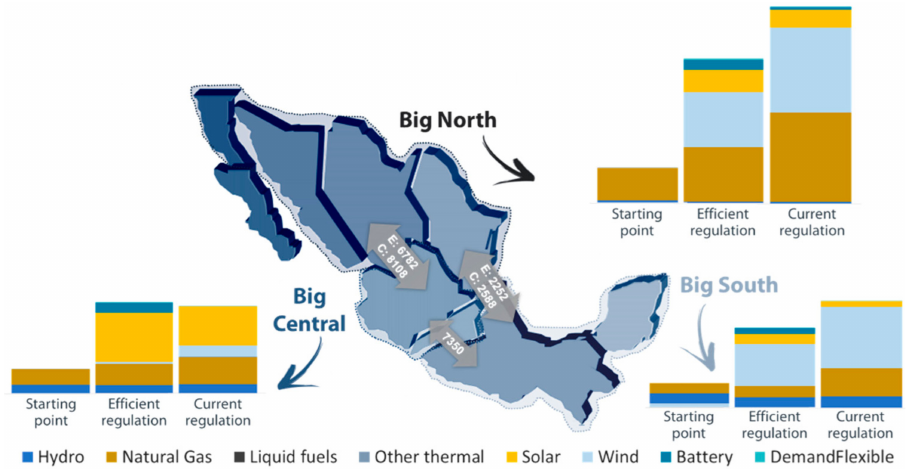
Figure 17. Comparison of the regional expansion between